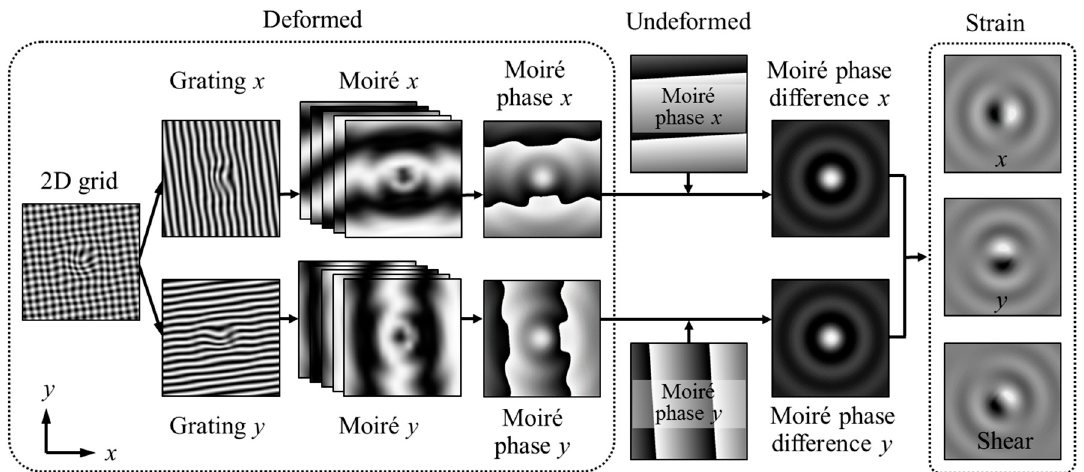
Figure 2 . Two-dimensional ( 2D) strain measurement process, from a 2D grid. Figure 2. Two-dimensional (2D) strain measurement process, from a 2D